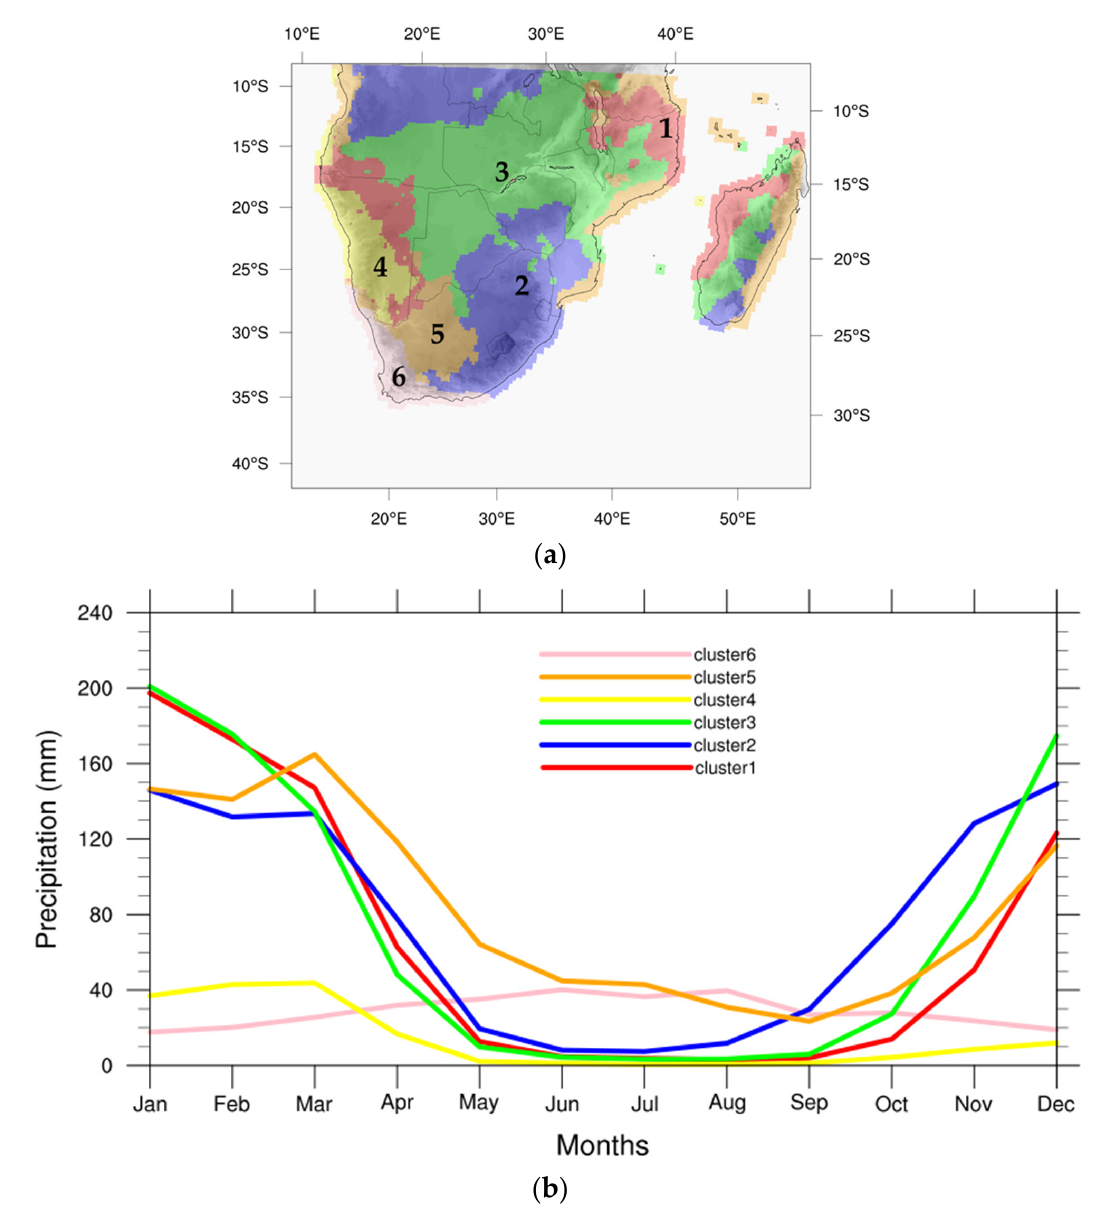
Figure 8. Same as in Figure 5, but for SA.